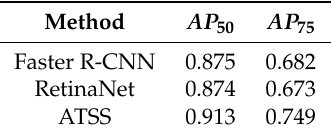
Table 2. Average precision for the object detection methods. To generate the ground truth, a fixed size bounding box of 40 × 40 was